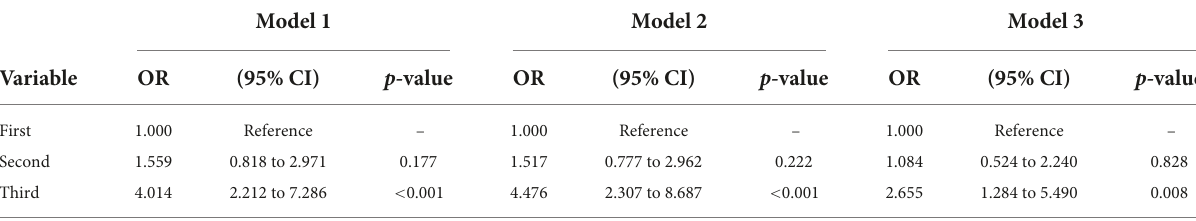
TABLE 3 Multivariate logistic regression analysis of the association between the homocysteine level and CKD according the tertiles of the homocysteine level. Model 1 Model 2 Model